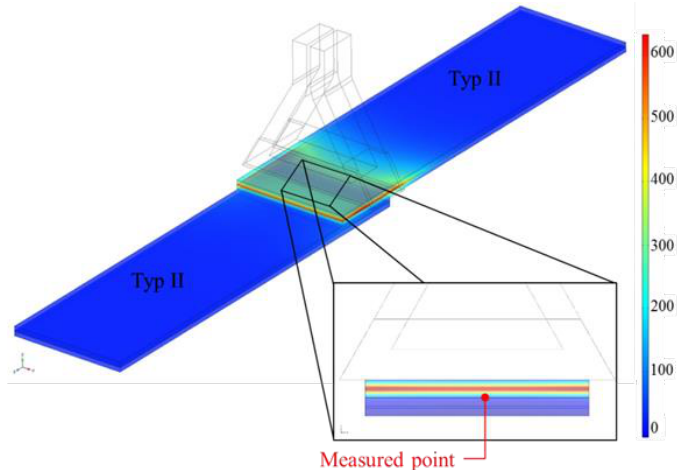
Figure 8. Simulation of the heating temperature of the ICJ process sample II+II.